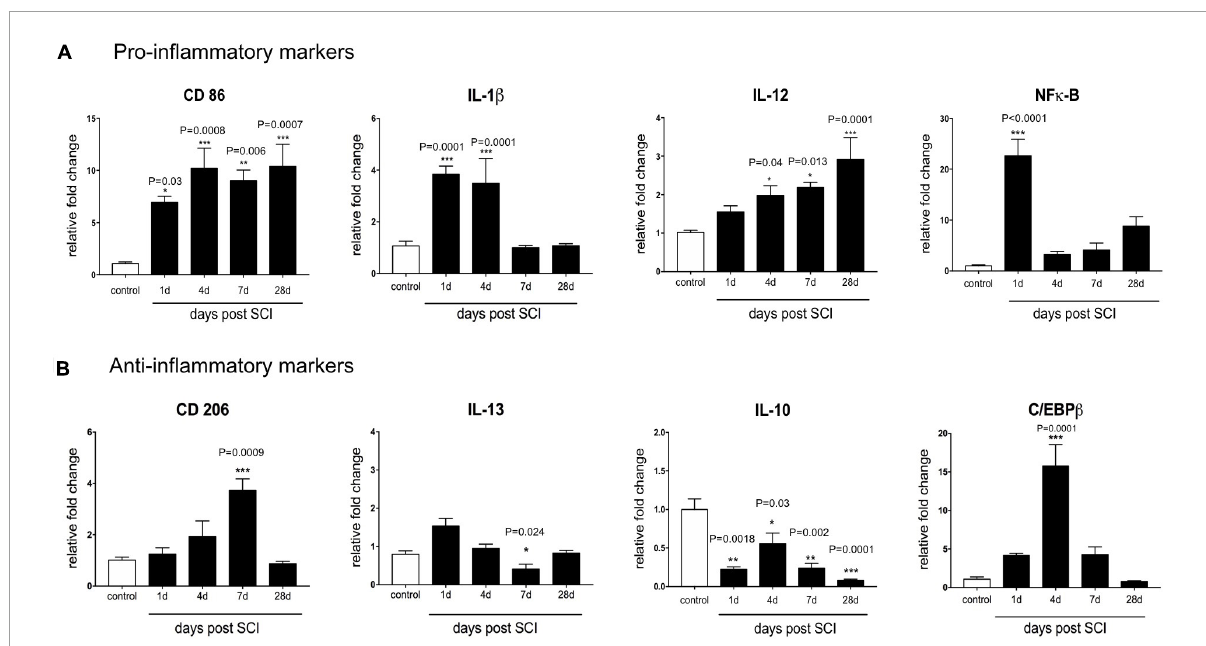
FIGURE2 Temporal changes in the mRNA expression level of inflammatory markers after contusive spinal cord injury. Real-time PCR quantification was used to evaluate the expression level of inflammatory-associated genes in the injured spinal cord at 1, 4, 7, and 28 days post-SCI. (A) SCI-induced pro-inflammatory activation genes included CD86, IL-12, IL-1 β , and NF- κ B. (B) Anti-inflammatory markers included CD206, IL-10, IL-13, and C/EBP β which were downregulated following SCI. n = 3 for each group. One-way ANOVA with Dunnett multiple comparison tests was used to compare gene expression levels (* P < 0.05, ** P < 0.01, *** P < 0.001). Data represented as mean ± SEM fold changes of gene